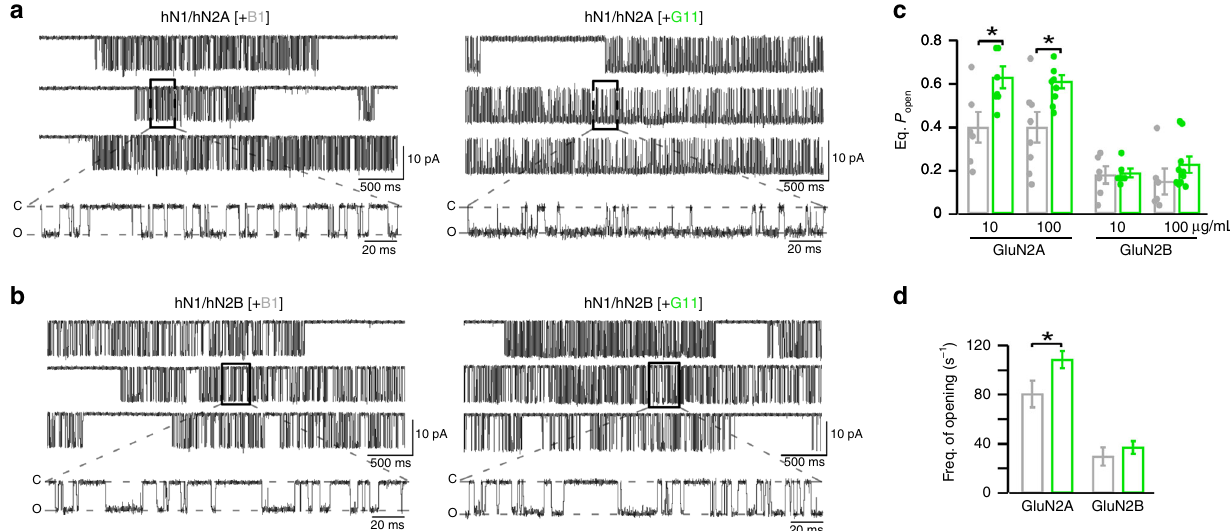
Fig. 2 Single-channel recordings of N2A- and N2B-containing NMDARs under continuous DNRAb exposure. a , b Example single-channel recordings of hGluN1/hGluN2A ( a ) and hGluN1/hGluN2B ( b ) with B1 (left traces) or G11 (right traces) antibodies at 10 μ g/ml. Recordings were made in the on-cell con fi guration (holding potential, + 100 mV). Downward de fl ections are inward currents. Low resolution top traces show 12 s of recording ( fi ltered at 1 kHz); more high-resolution bottom traces (selection in black box) show 230 ms ( fi ltered at 3 kHz). c Equilibrium open probability (Eq. P open ) (mean ± SEM) for N2A- or N2B-containing NMDARs (from left to right for hN1/nN2A, n = 6, 7, 8, 8 cells recorded; for hN1/hN2B, n = 6, 6, 6, 10 cells recorded). Antibody was either B1 (gray) or G11 (green) ( *p < 0.05, two-sided t test) (left to right for N2A, p = 0.0335, 0.0226; left to right for N2B, p = 0.745, 0.0556). d DNRAbs enhance forward rates of activation. Frequency of single-channel openings (mean ± SEM) derived from samples in c with antibody either B1 (gray) or G11 (green) ( *p < 0.05, one-sided t test) (left to right, p = 0.0270, 0.212). Test DNRAbs was 100 μ